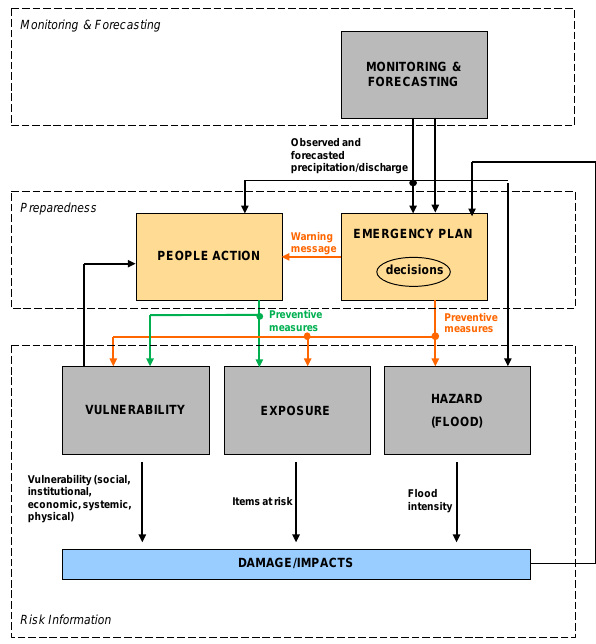
Fig. 1. Scheme of emergency activities linked to EWS. Coloured Figure 1. Scheme of emergency activities linked to EWS. Coloured arrows represent 2 arrows represent mitigation measures implemented during a warn- mitigation measures implemented during a warning, whose effects need to be modelled. The 3 ing, whose effects need to be modelled. The scheme also shows how sub-systems of an EWS can be mapped on the scheme also shows how EWSs’ sub-systems can be mapped on the scheme. 4